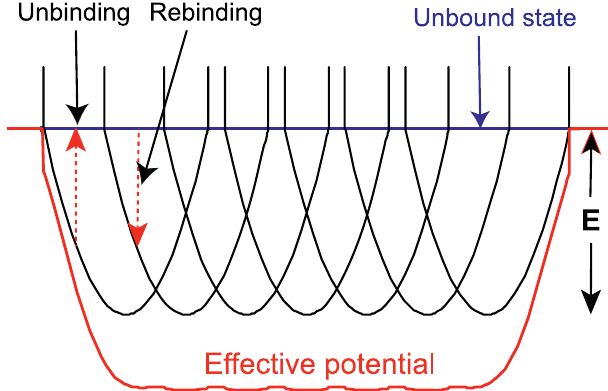
Figure 5. Discrete Overlapping FG-Repeat Regions Can Be Approximated by a Smooth Effective Potential Transport through the NPC can be represented as diffusion in an array of potential wells (solid black lines) that represent flexible FG-repeat regions whose fluctuation regions overlap. The red dotted arrows correspond to the complexes unbinding from and rebinding to the FG- repeat regions. The solid blue line represents the unbound state. The solid red line shows the equivalent potential in the case when the unbinding of the complexes from the FG-repeat regions is much faster than the lateral diffusion across an individual well.